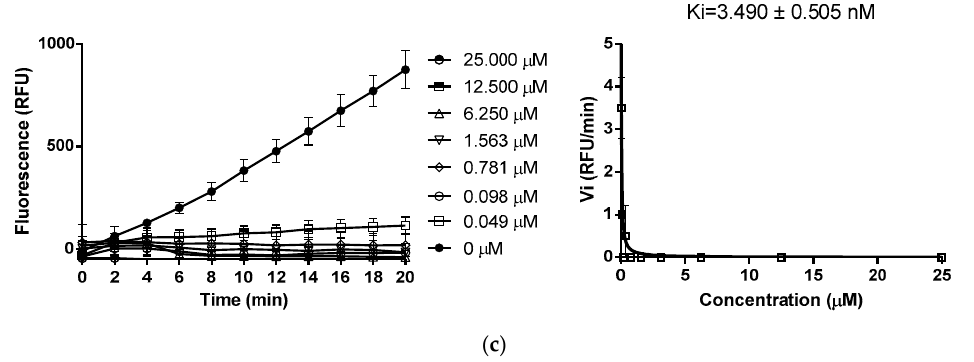
Figure 6. Trypsin/chymotrypsin inhibitory activities: ( a ) Reactive curves and corresponding Morrison plot of trypsin inhibition of Kunitzin-OV in various concentrations; ( b ) Reactive curves and corresponding Morrison plot of chymotrypsin inhibition of F 9 -Kunitzin-OV in various concentrations; ( c ) Reactive curves and corresponding Morrison plot of trypsin inhibition of ovomucoid inhibitor (chicken) in various concentrations.